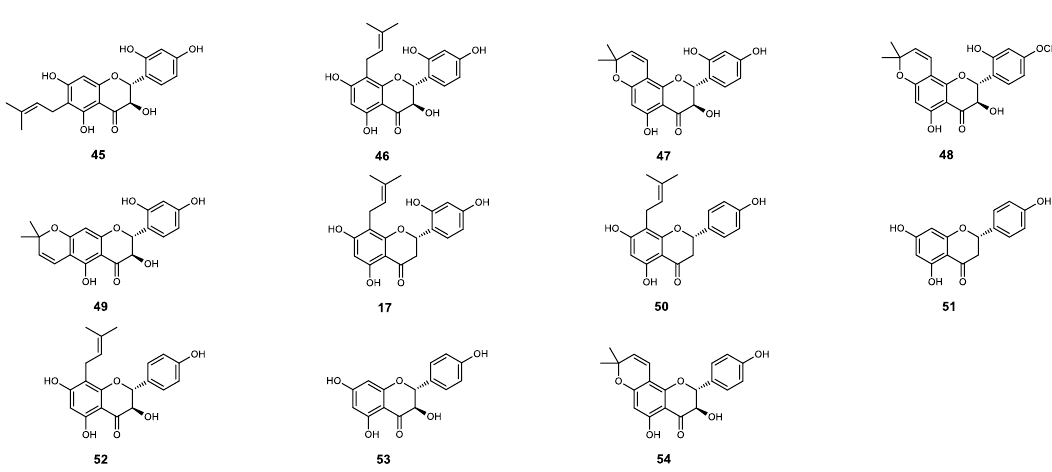
Figure 5. Chemical structures of compounds 17 , and 45 to 54 14